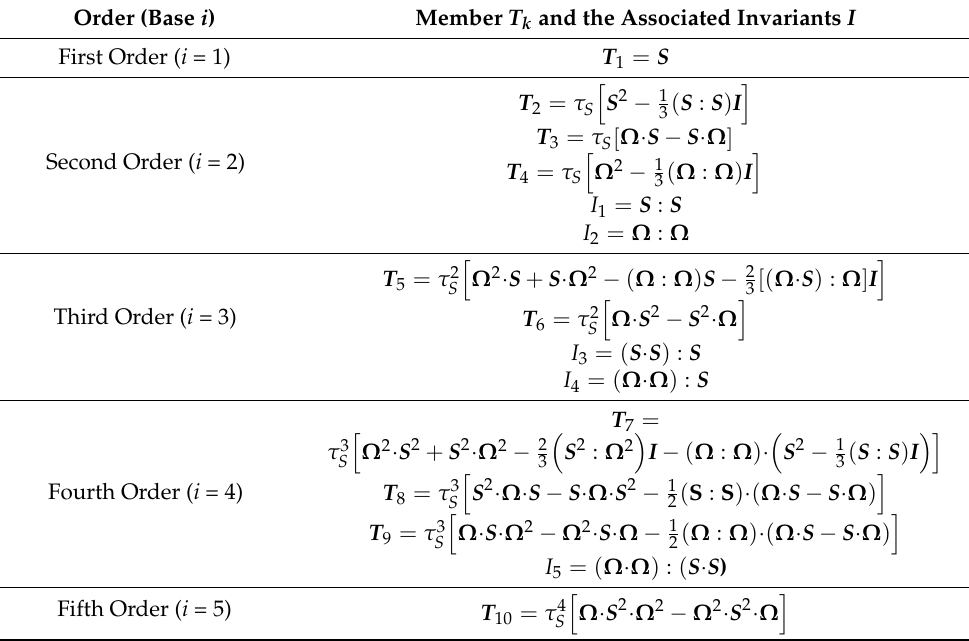
Table 2. Tensor base defined by the tensor T p and invariants I q for the turbulent anisotropy tensor. For simplicity, we dropped the two index notations and define them in the table: T 1 = T 11 , T 2 = T 21